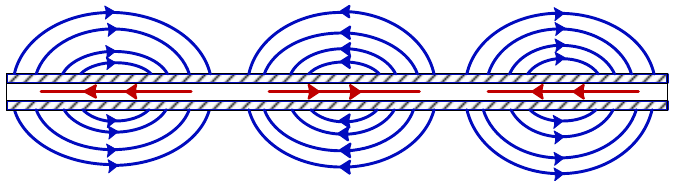
Figure 3. Current distribution on single-wire.